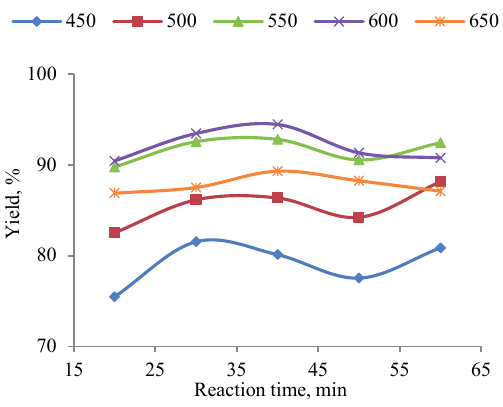
Fig. 5. Effect of mixing time on the biodiesel conversion rate from Waste Soybean Oil.